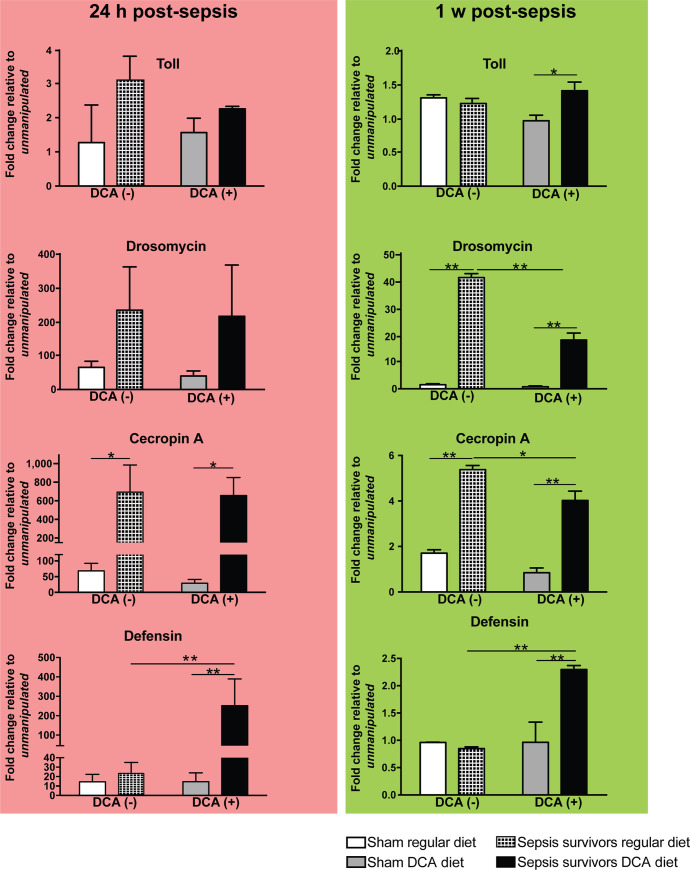
DCA selectively affects early and late AMP expression patterns in Drosophila surviving sepsis.Flies were infected with Staphylococcus aureus and then treated with orally available linezolid (0.5 mg/mL) in the diet for 18 hours. DCA treatment continued for one week after the initial infection and it was also incorporated into the diet (DCA, 0.5 mg/mL). AMP transcription was assessed after 24 h and 1 week surviving sepsis by quantitative PCR and normalized to unmanipulated flies in each respective diet group. Significant different expression values across treatment within each antimicrobial peptide transcript were determined by one-way ANOVA and Tukey’s multiple comparison tests (*<0.05 and **<0.01). After 24 h surviving sepsis, cecropin A expression was significantly elevated regardless of the diet exposure. However, only the DCA exposed flies had significantly elevated defensin expression levels. After 1 week surviving sepsis, addition of DCA significantly decreased the expression of cecropin A and drosomycin while increasing defensin expression. The number of biological repeats for qPCR was n = 6.